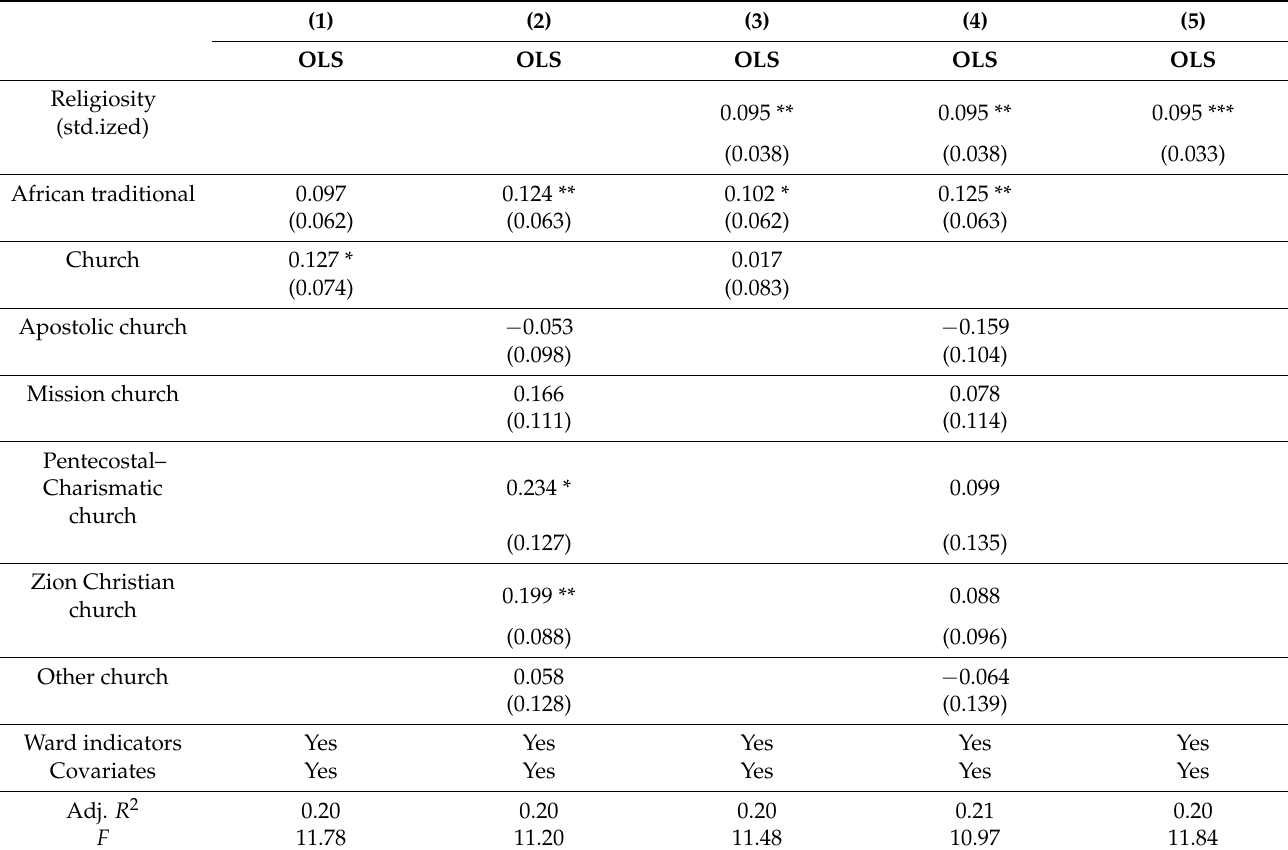
Table A1. Results ordinary least squares